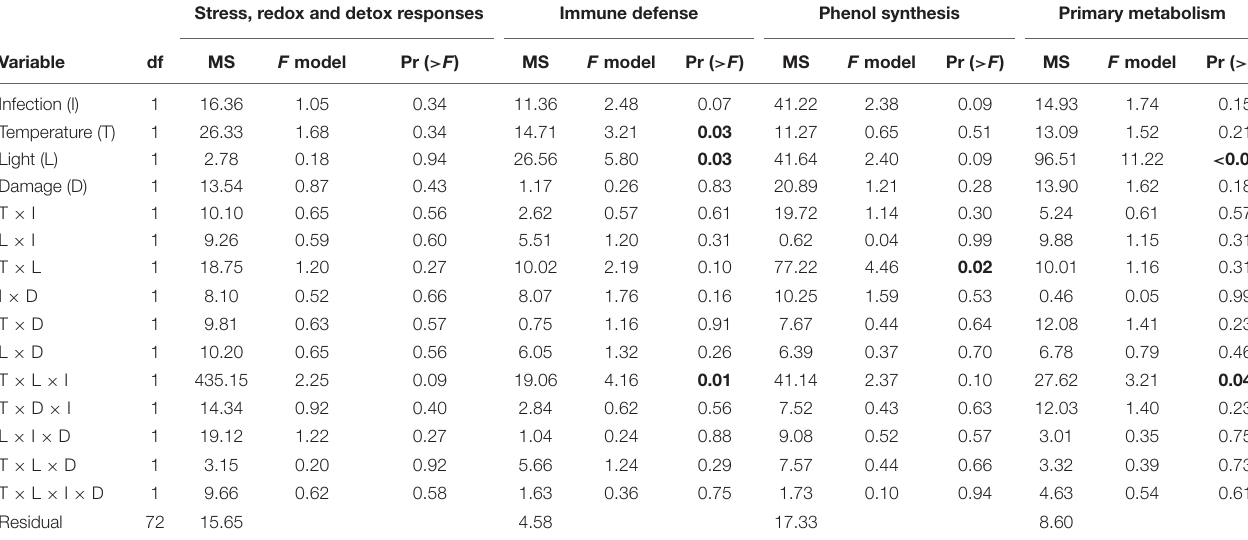
TABLE 6 | Permutational analysis of variance of expression of genes associated with different functions (stress, redox, and detox responses, immune defense, phenol synthesis, and primary metabolism) in Zostera marina in response to different levels and combinations of temperature (ambient and increased), light (reduced and ambient), tissue damage (damaged and undamaged), and Labyrinthula zosterae infection (non-inoculated and